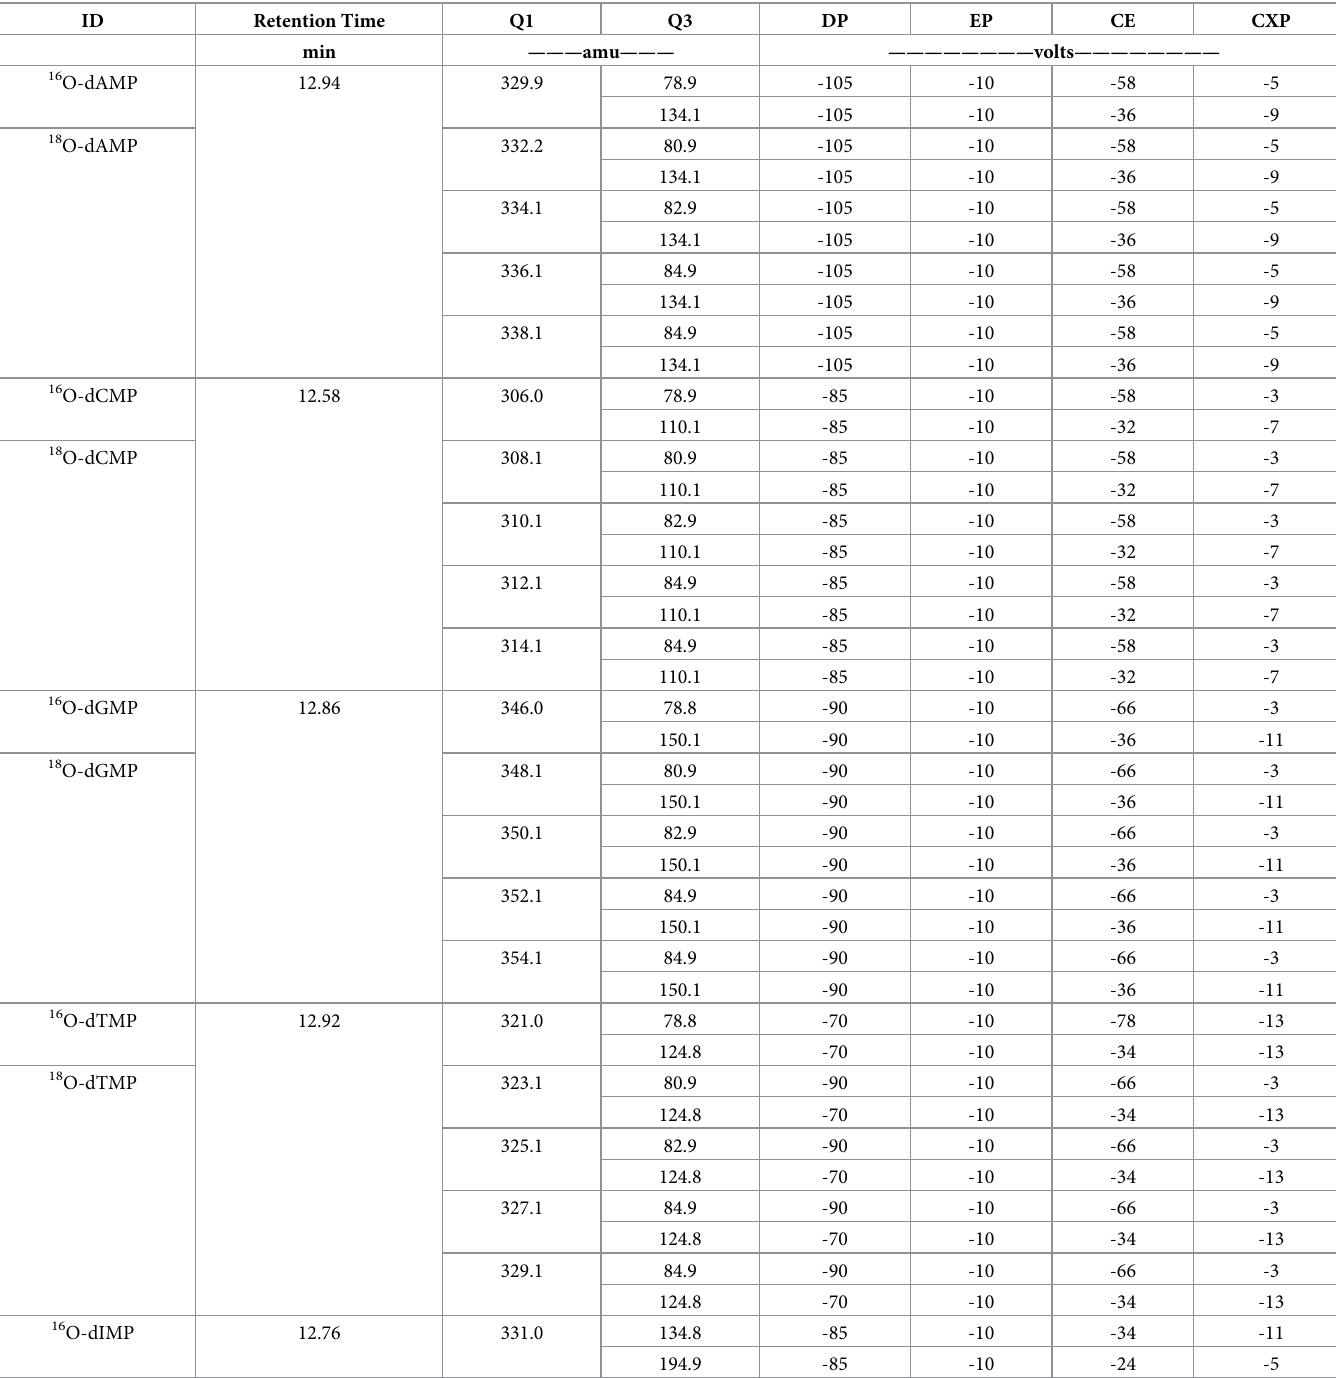
Table 2. The mass spectrometry parameters for quantification of 16 O- and 18 O-dNMP, and internal standard dIMP.